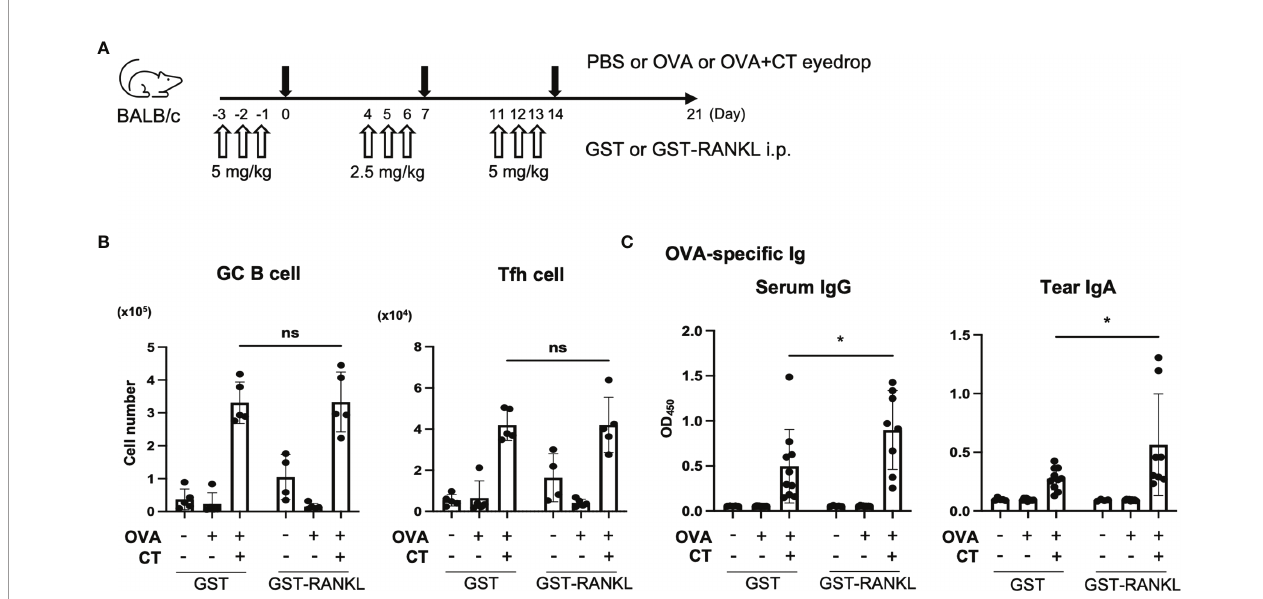
FIGURE 7 | Administration RANKL enhances immune response in the eye region. (A – C) BALB/c mice were intraperitoneally injected GST or GST-RANKL and immunized by eye drops as illustrated in panel (A) ( fi rst and third week: 5 mg/kg, second week: 2.5 mg/kg). (B) The number of GC B cells and Tfh cells in the cLN and smLN was quanti fi ed by fl ow cytometry. Representative data are shown from two independent experiments. ns not signi fi cant (two-way ANOVA, PBS/GST: n = 5, OVA/GST: n = 5, OVA + CT/GST: n = 5, PBS/GST-RANKL: n = 4, OVA/GST-RANKL: n = 5, OVA + CT/GST-RANKL: n = 5 animals). (C) Quanti fi cation of OVA-speci fi c serum IgG and tear IgA by ELISA. Data were pooled with two independent experiments and are presented as the mean ± standard deviation. * P < 0.05 (two-way ANOVA, PBS/GST: n = 5, OVA/GST: n = 10, OVA + CT/GST: n = 10, PBS/GST-RANKL: n = 4, OVA/GST-RANKL: n = 9, OVA + CT/GST-RANKL: n = 8 animals from two independent